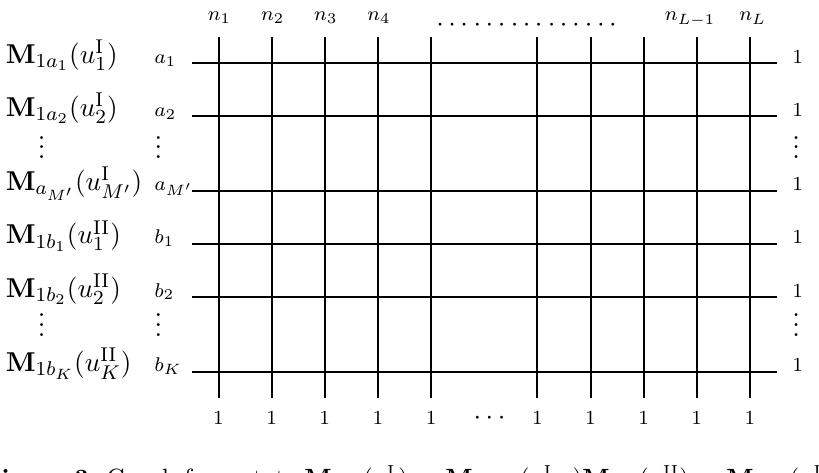
( u I ) · · · M 1 a ( u I ) M 1 b ( u II ) · · · M 1 b ( u II ) | 0 i . 1 1 M 0 K 1 1 K M 0